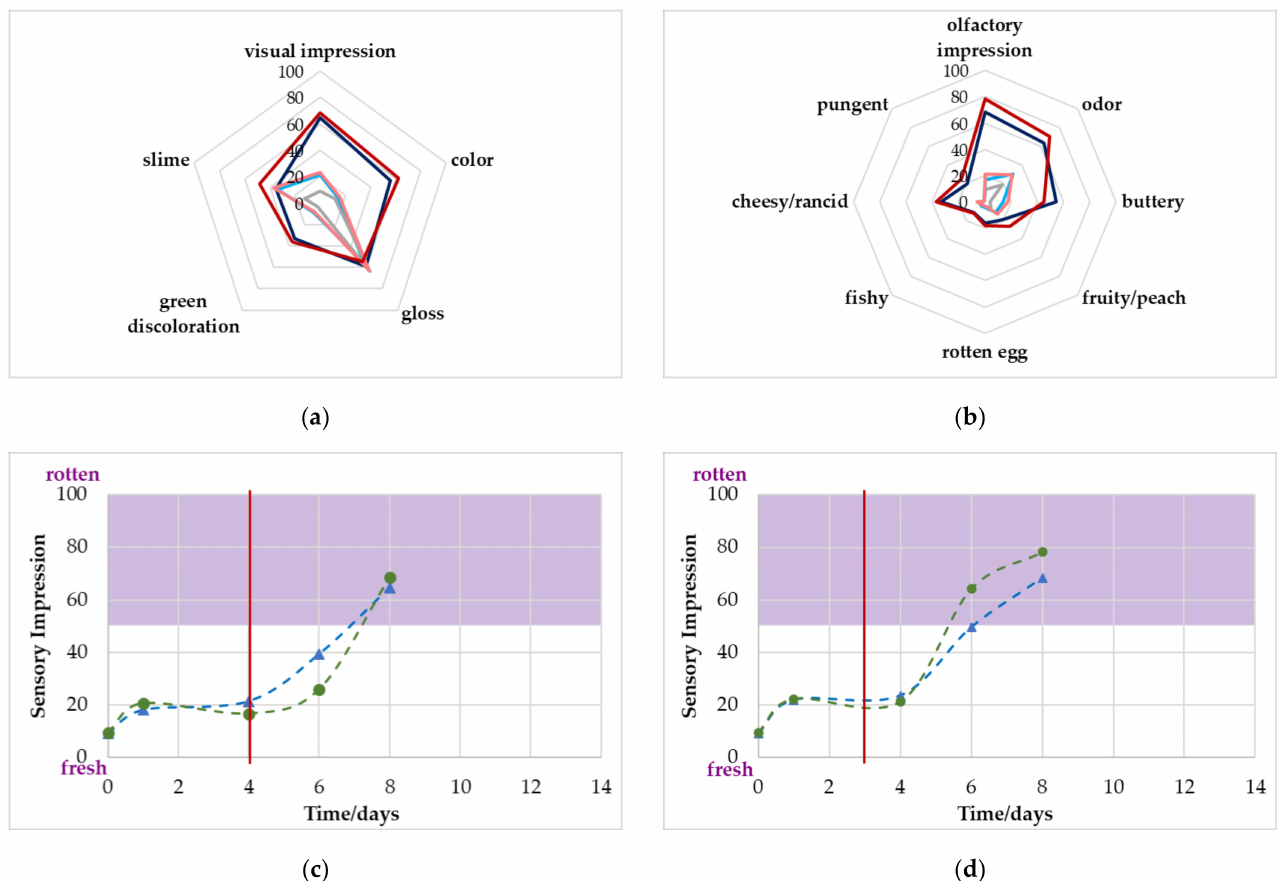
Figure 6. ( a , b ): Sensory evaluation of poultry stored at 10 ◦ C by the panel with the chosen descriptors for ( a ) visual and ( b ) olfactory attributes on day 0 (grey line), after reaching the critical value of 10 7 CFU/g (70% O 2 /30% CO 2 : light blue; 80% O 2 /20% CO 2 : pink) and on day 8 (70% O 2 /30% CO 2 : dark blue; 80% O 2 /20% CO 2 : red). ( c , d ): Change in the overall visual ( (cid:78) ) and olfactory ( • ) impression during the storage time: ( c ) 70% O 2 /30% CO 2 10 ◦ C and ( d ) 80% O 2 /20% CO 2 10 ◦ C. The red line marks the point when the microbiological limit value was achieved. The purple area indicates the previously defined sensory limit of 50